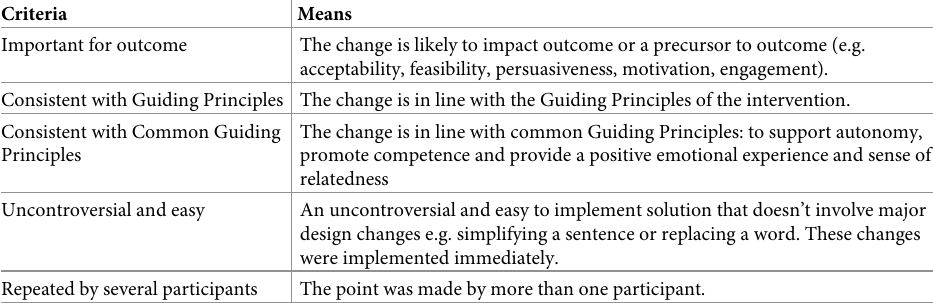
Table 3. Criteria for deciding whether to make a change to the intervention components.